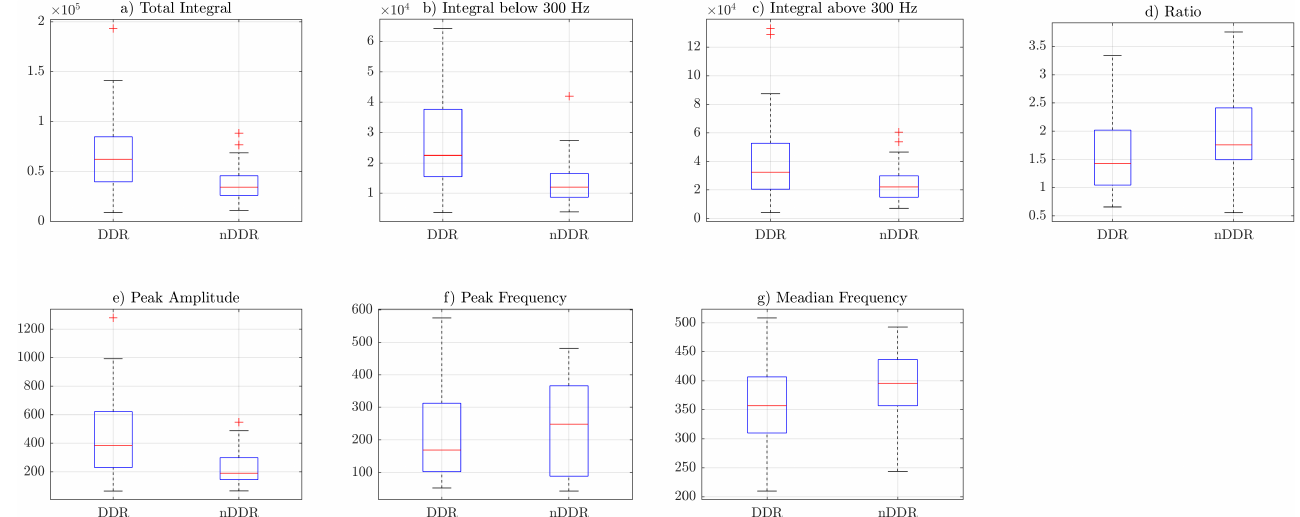
Figure A3. Box plots of norm1 features obtained for the first measurement: ( a ) TI feature, ( b ) IB3 feature, ( c ) IA3 feature, ( d ) IBAR feature, ( e ) PA feature, ( f ) PF feature, ( g ) MF feature.